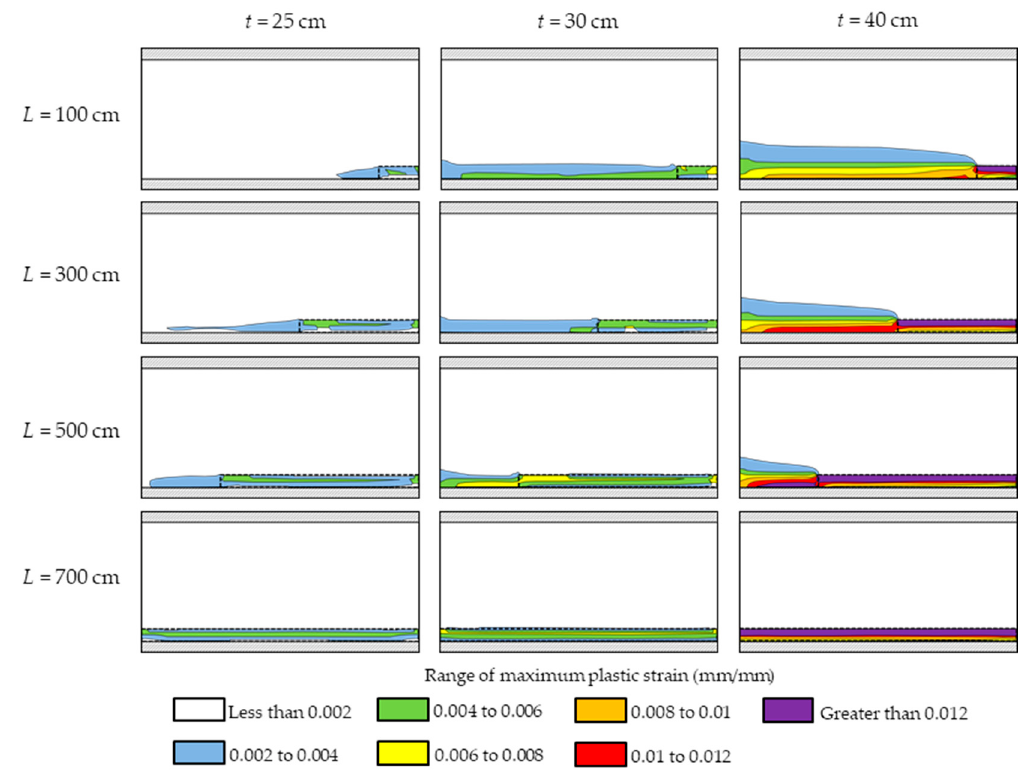
Figure 7. Maximum in-plane plastic strain distribution at end of loading for Scenario w ps in the interior wall face (face in